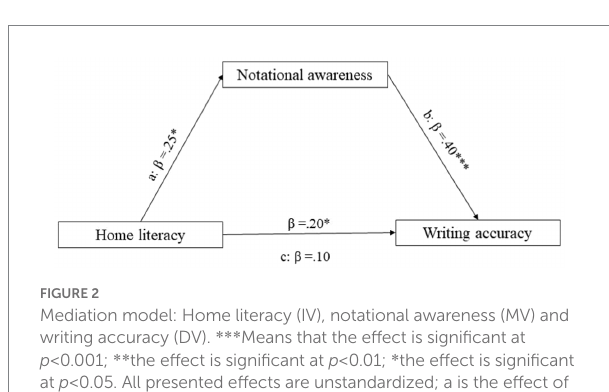
FIGURE 2 Mediation model: Home literacy (IV), notational awareness (MV) and writing accuracy (DV). *** Means that the effect is significant at p < 0.001; ** the effect is significant at p < 0.01; * the effect is significant at p < 0.05. All presented effects are unstandardized; a is the effect of home literacy on notational awareness; b is the effect of notational awareness on writing accuracy; β is the indirect effect of home literacy on writing accuracy; c is the total effect of home literacy on writing